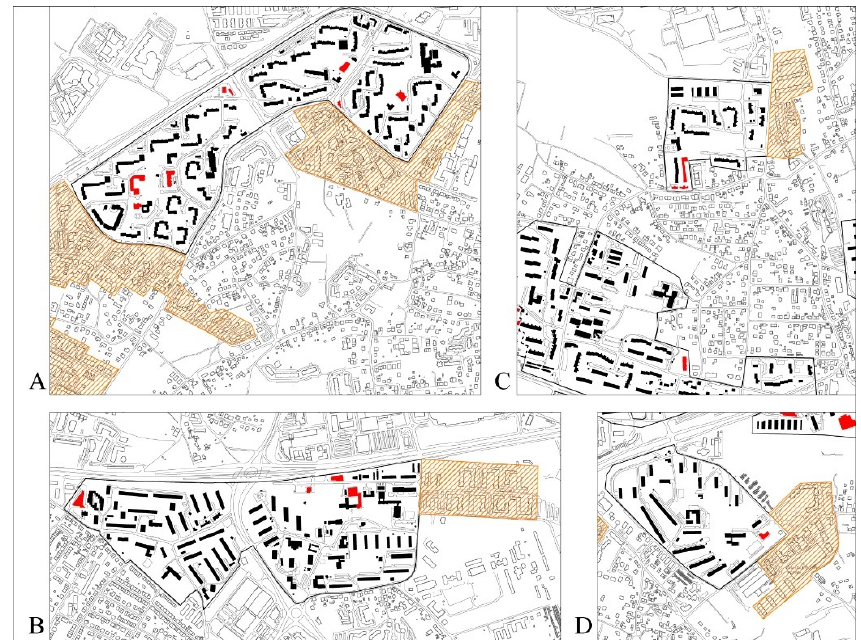
Figure 6. Neighborhood of clusters of multi-family buildings with the dominating residential function—examples in the context of selected housing estates: ( A )—Ruczaj (22), ( B )—Olsza II (7), ( C )—Wola Duchacka Zachód—northern part (4), ( D )—Piaski Nowe (28). Color legend: black— developments from before 1995; red—densification—developments from after 1995; orange—other multi-family housing areas next to the large-panel housing estates.